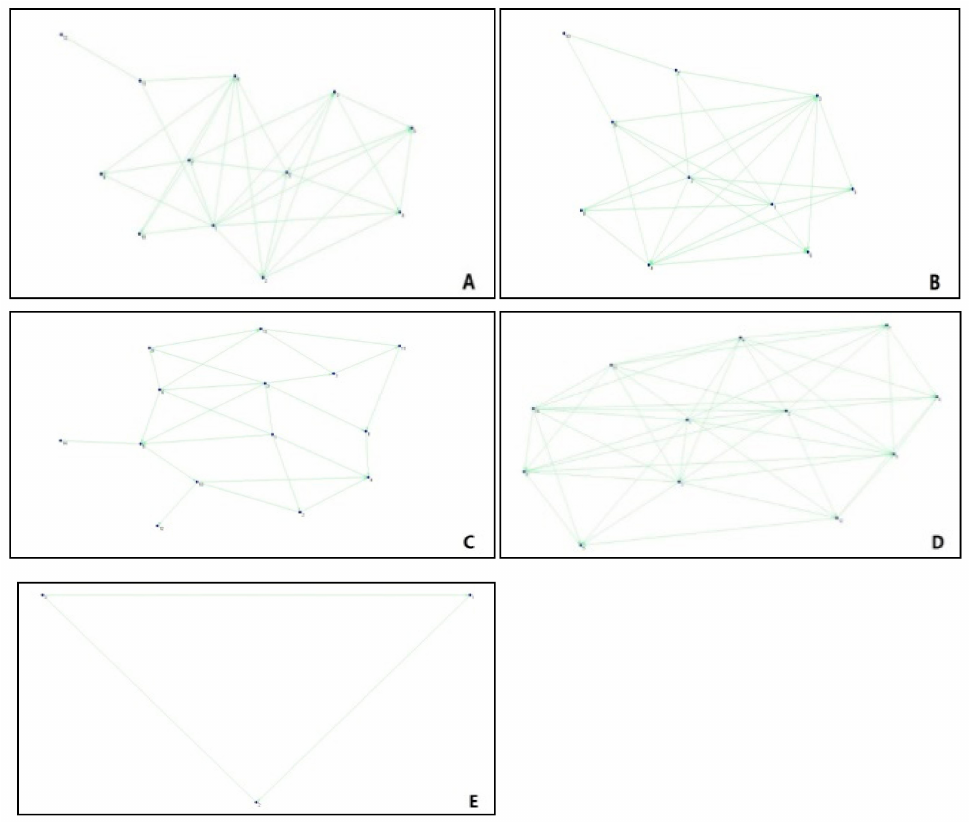
Figure 6. Network Structures of Cohesive Subgroup of Typhoon